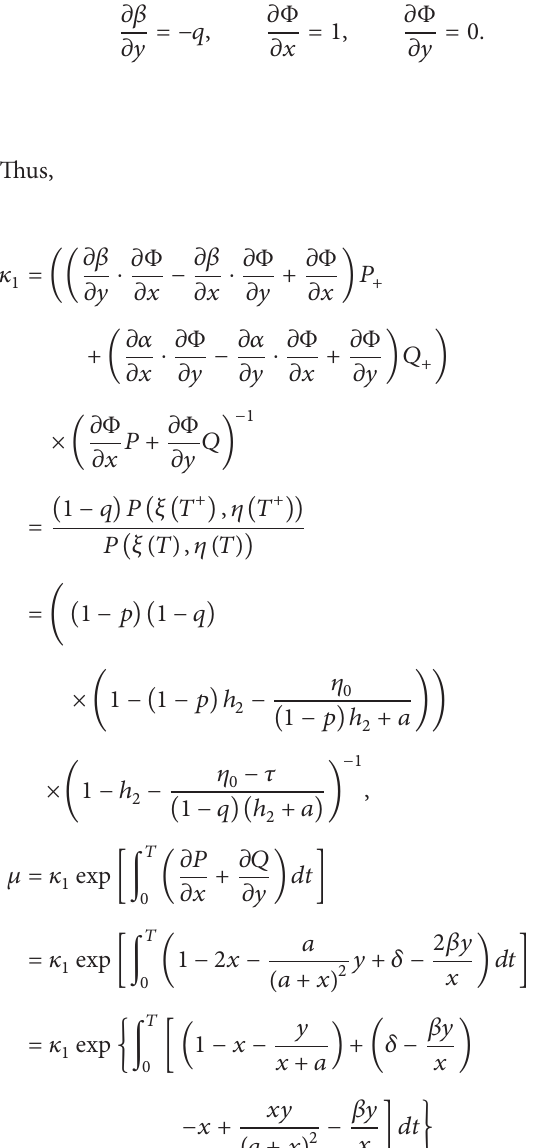
Figure 6: The initial point 𝐶 0 on 𝑁 2 (Case III: 𝑦 𝐶